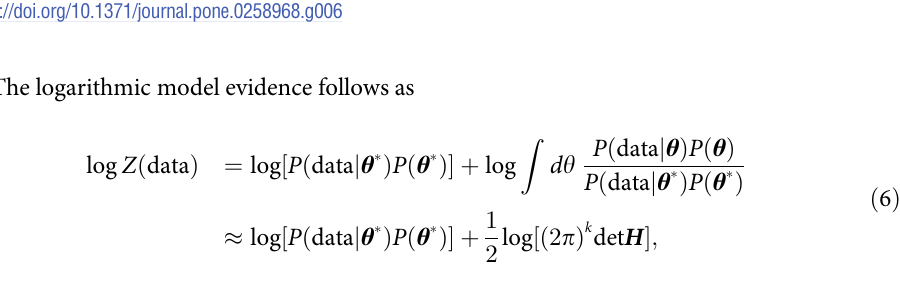
Fig 6. Logarithm of the posterior distribution along a slice ofthe parameter space. Data for model variants BC1 (blue) and C1 (orange) are shown. The computed posterior is shown as points, the Gaussian approximation of Eq (5) is shown as solid lines. We vary the onset time (left) and the factor (right) of the change in IFR around the value of θ � , keeping all other parameters fixed. Values shown for the log-posterior are the difference to the maximal values for models BC1 and C1,